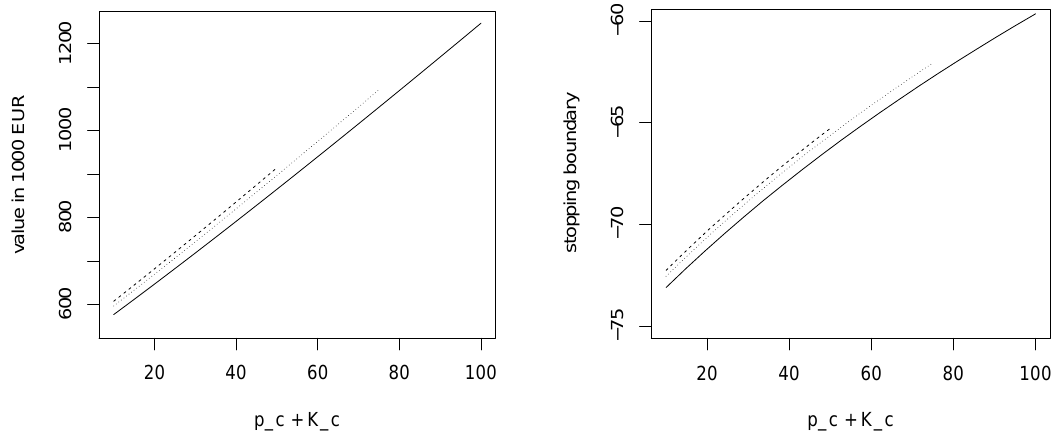
Figure 3. Results obtained with the Ornstein-Uhlenbeck model fitted in Section 4, as functions of the total premium, with interest rate 3% per annum. Solid lines: x ∗ = 100, dotted: x ∗ = 75, dashed: x ∗ = 50. Left: lifetime value (cid:98) V ( x ∗ ) . Right: the stopping boundary ˇ x , the maximum price for which the battery operator can buy energy optimally.